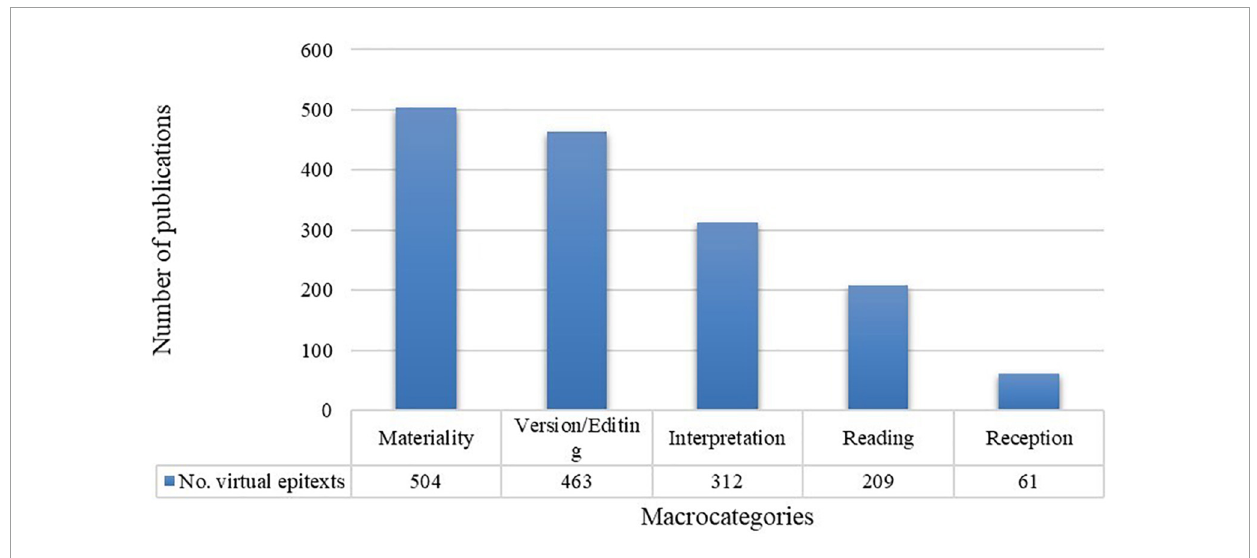
FIGURE3 Macrocategories detected in the virtual